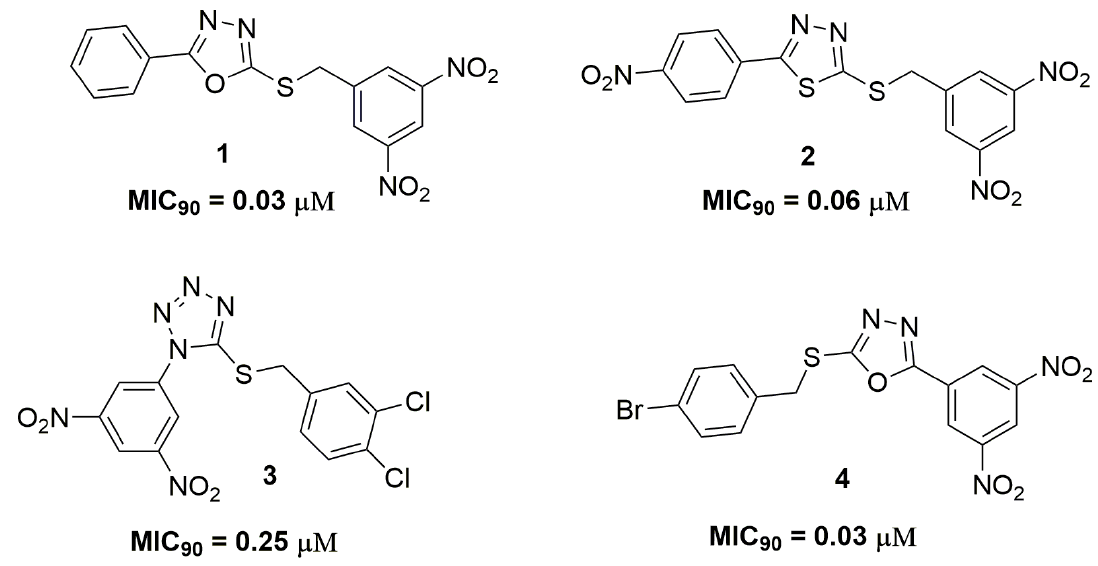
Figure 1. Nitro-containing compounds with antituberculosis activity. MIC: minimum inhibitory concentration.